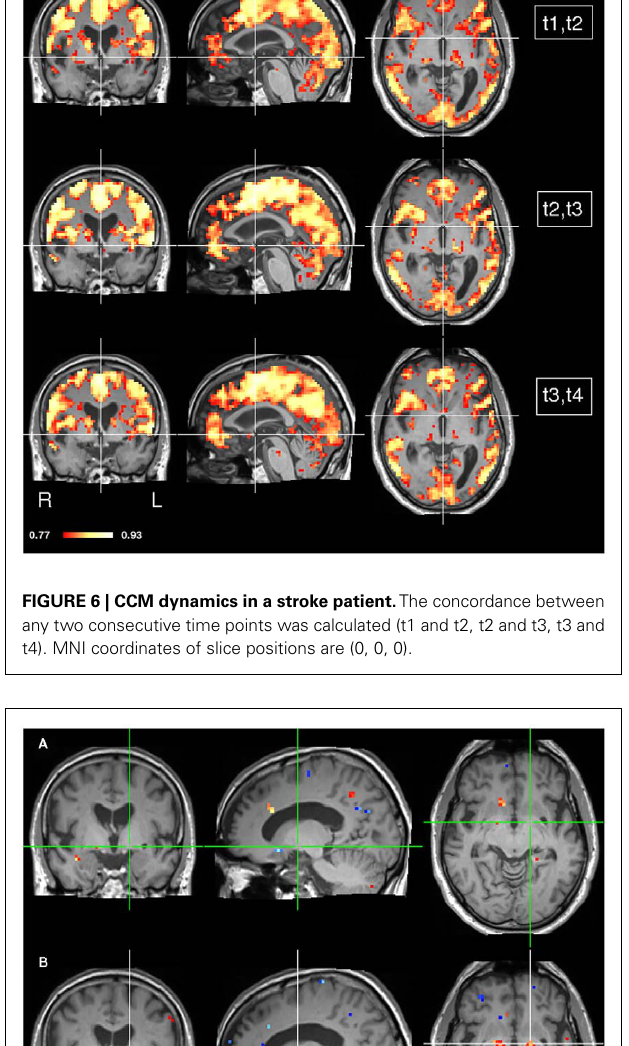
can differentiate between different functional states.A comparison between Kendall’s W and OCCC as measures of concordance did not show major differences. However, since OCCC presupposes Gaussianity of the data, we suggest to use Kendall’s W because it is applicable to a wider range of